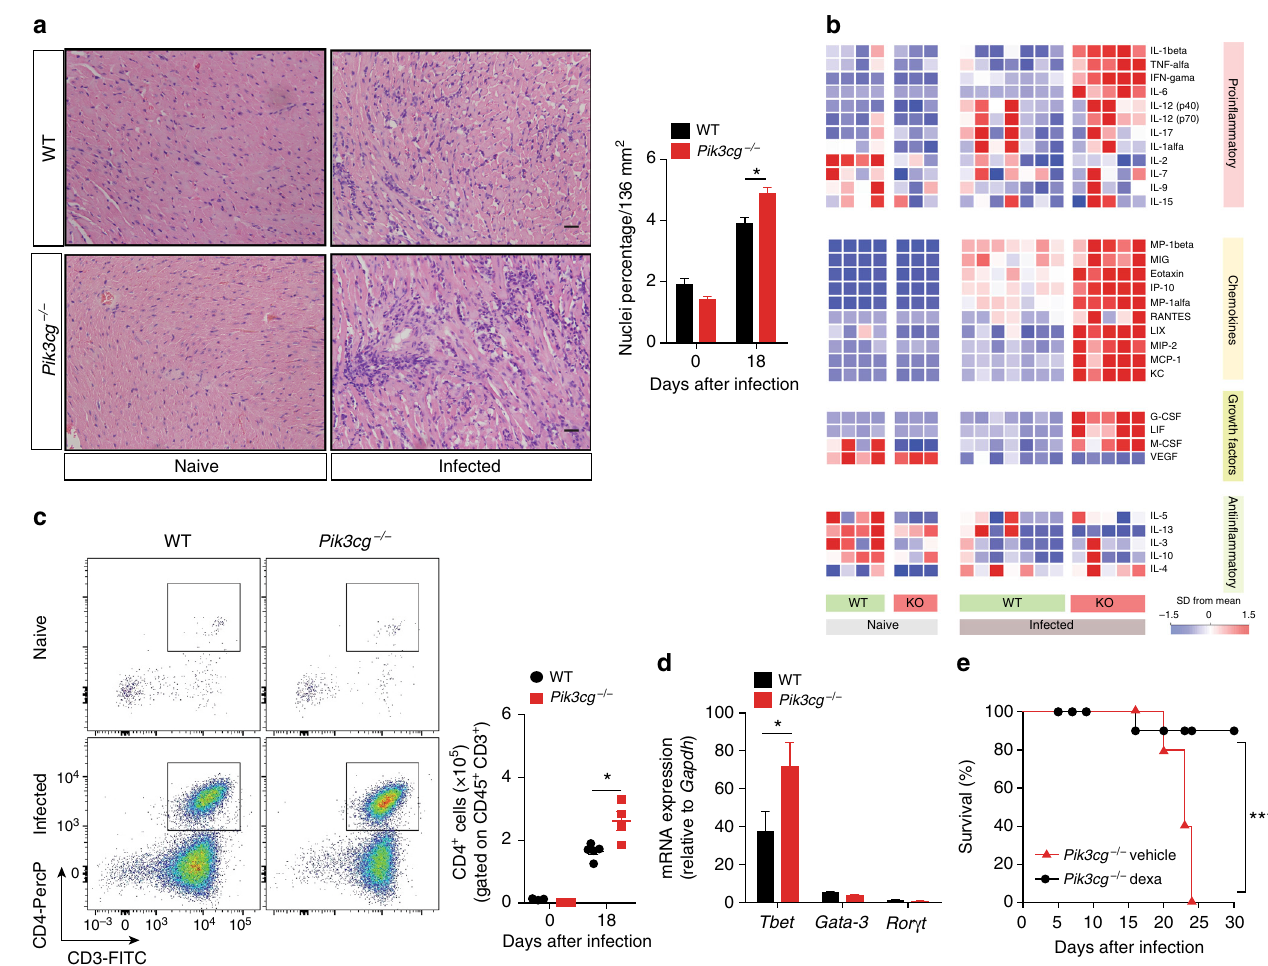
Fig. 4 PI3K γ controls the heart in fl ammation after infection with T . cruzi . a Representative images from H&E staining of heart tissue from non-infected WT ( n = 6) and Pik3cg − / − ( n = 6) mice or 18 days after infection with 10 3 trypomastigote forms of T . cruzi Y strain. Scale bar = 50 μ m. b Heat map demonstrating the pro fi le of cytokines and chemokines produced in the heart tissue of non-infected WT and Pik3cg − / − mice or 18 days post infection with 10 3 trypomastigote forms of T . cruzi Y strain. c Representative fl ow cytometry plots for the analysis of CD4 staining and quanti fi cation of the number of positive cells in the heart tissue of WT ( n = 5) and Pik3cg − / − ( n = 4) naive mice or infected with T . cruzi Y strain. d PCR analysis of mRNA expression of the transcription factors Tbet , Gata-3 , and Ror γ t in the heart tissue of WT ( n = 4) and Pik3cg − / − ( n = 4) mice. Gapdh was used as a housekeeping gene. e Survival rate of Pik3cg − / − mice infected with 10 3 trypomastigote forms of T . cruzi Y strain and treated at day 9 post infection with 2 mg Kg − and at days 12 and 15 post infection with 1 mg Kg − of dexamethasone ( n = 5) or vehicle ( n = 5). * P < 0.05 and *** P < 0.001 (one-way ANOVA with Tukey ’ s post hoc test in a , unpaired Student ’ s t- test in c , d , and Mantel – Cox log-rank test in e ). Data are representative of two ( b , e ) or three ( a , c , d ) independent experiments (mean ± s.e.m in a , c , d